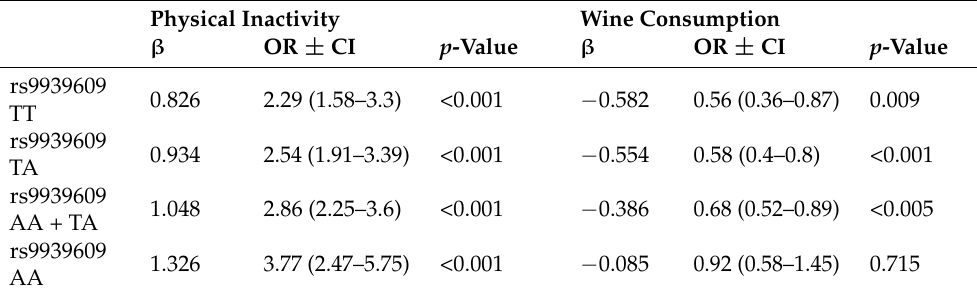
Table 5. Physical inactivity and wine consumption effect on FTO rs9939609 obesity